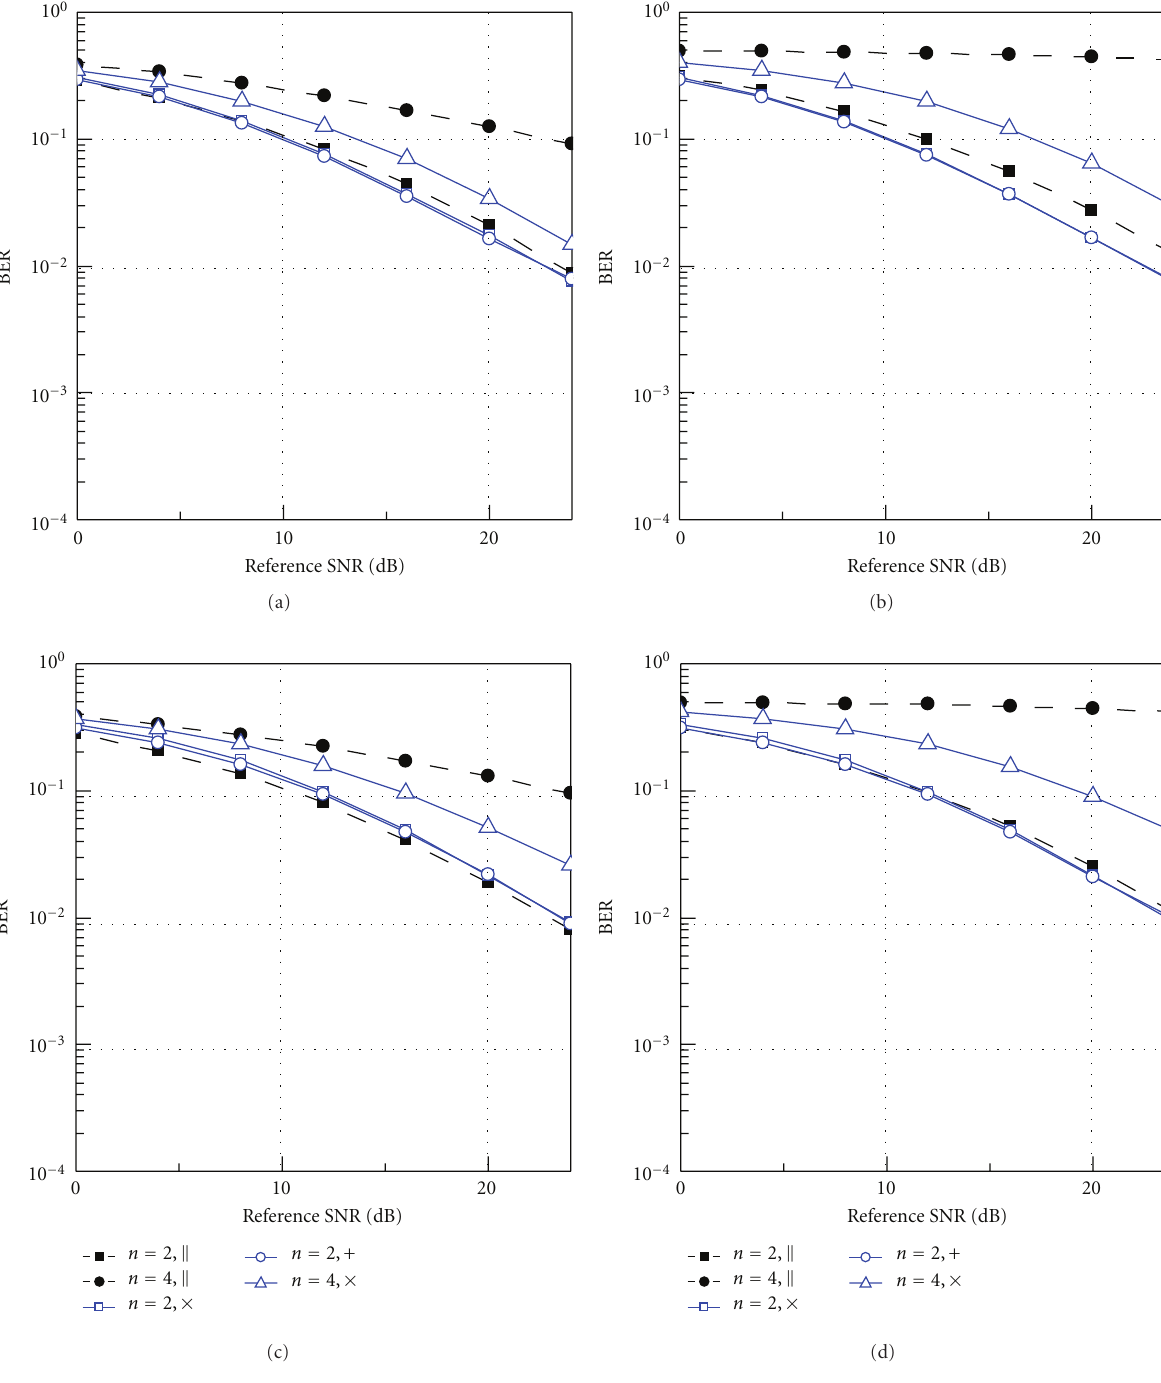
Figure 7: BER performances of zero-forcing receivers for space-time coding MIMO systems with polarization diversity when: (a) matched, XPD = 0dB; (b) unmatched, XPD = 0dB; (c) matched, XPD = –6dB; (d) unmatched, XPD = –6